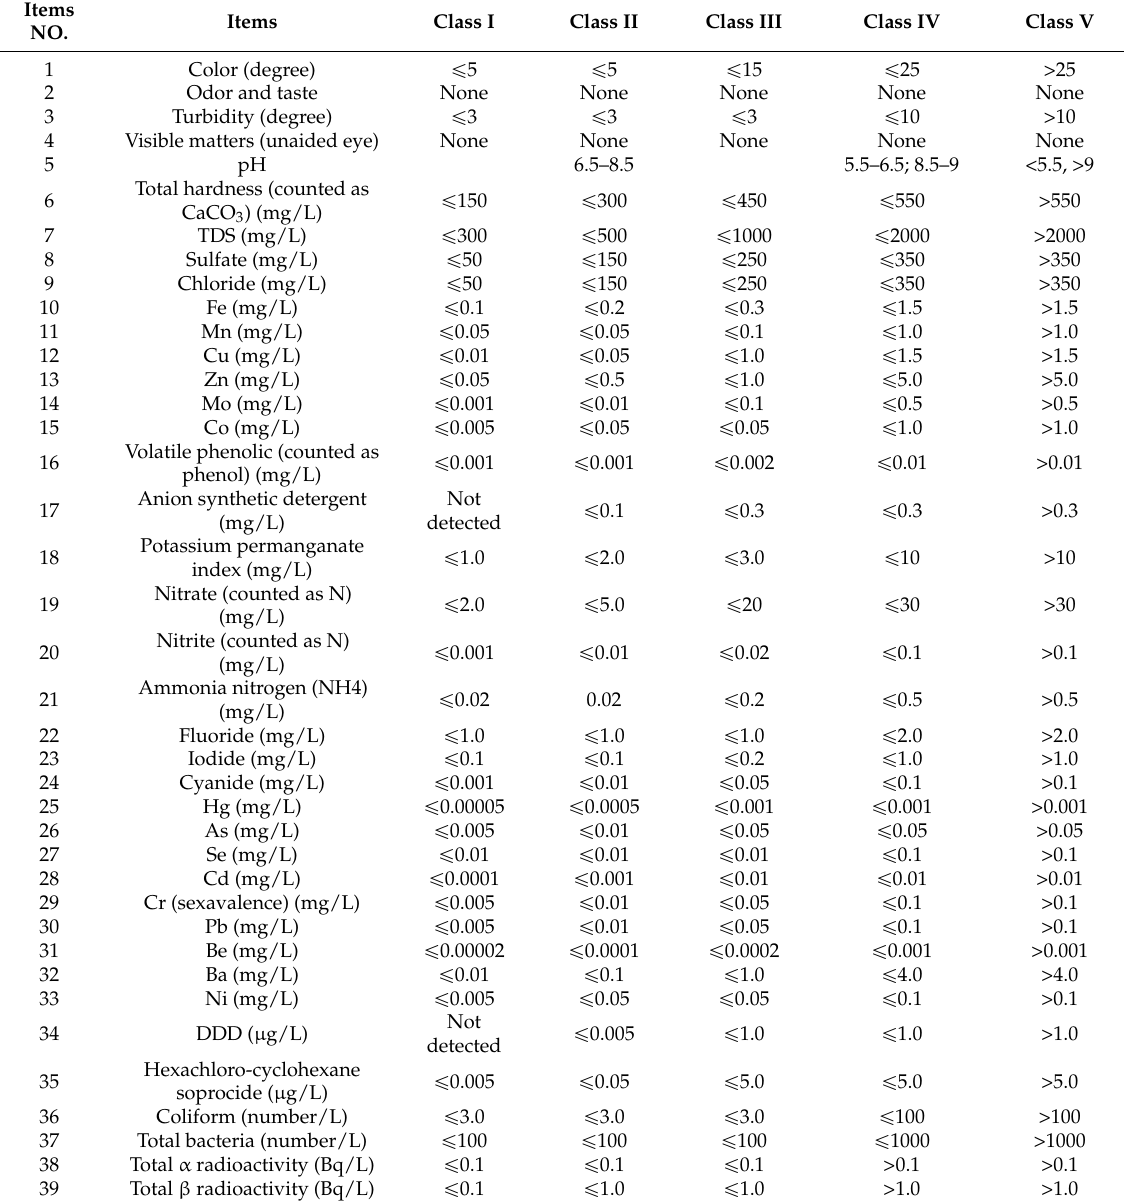
Table A2. Quality standard for groundwater (GB/T